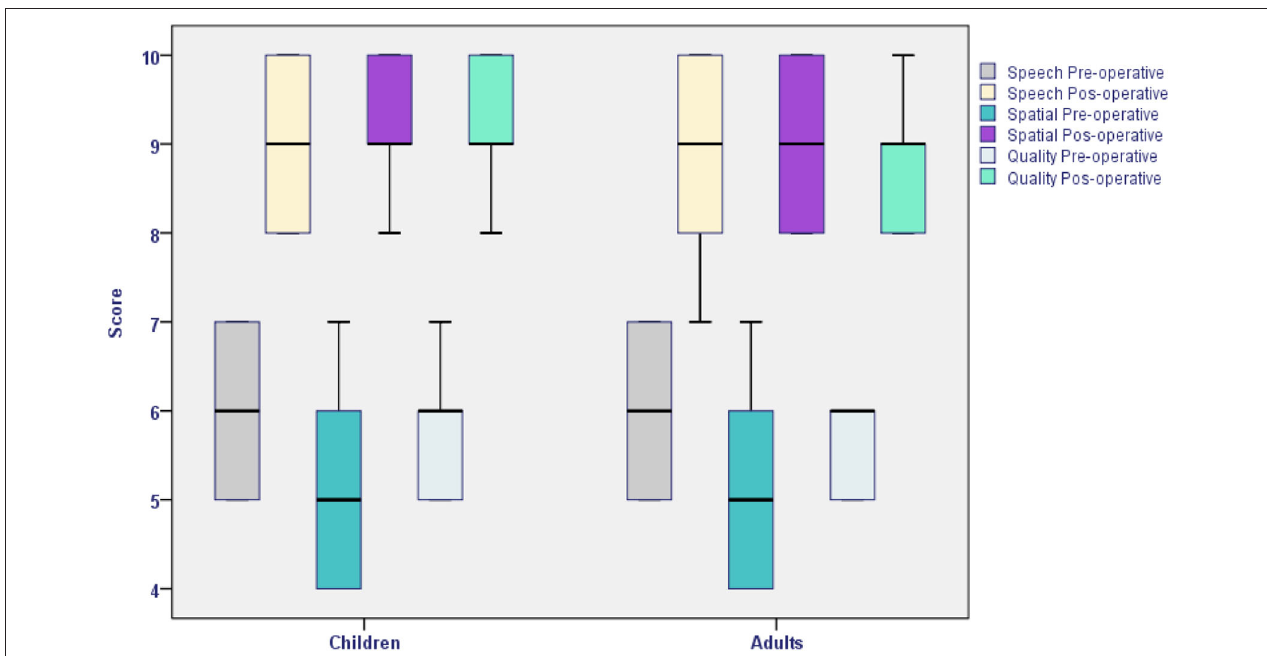
FIGURE 2 | Speech, Spatial, and Qualities of Hearing Scale questionnaire results of the children and adult single-sided deafness groups ( p >